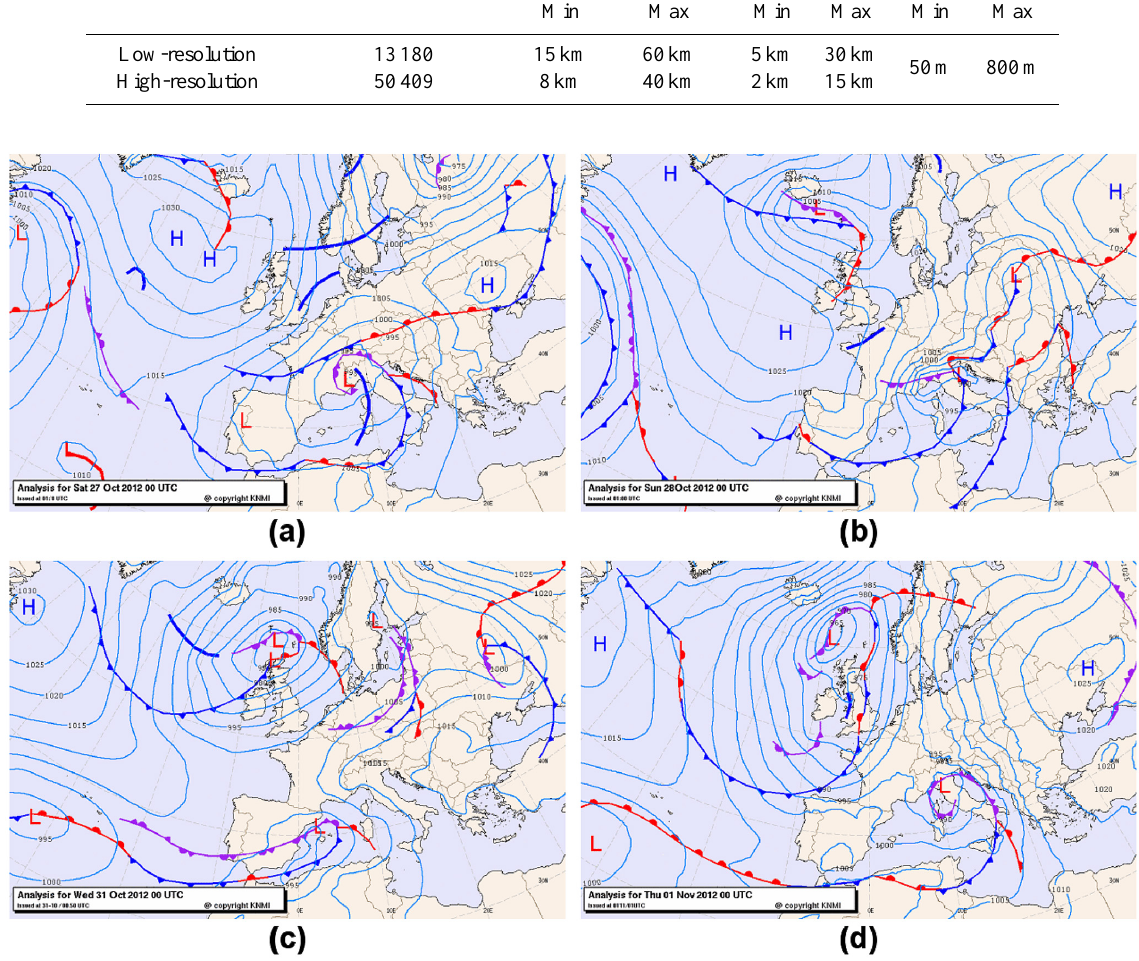
Figure 5. Synoptic analysis charts at 00:00UTC. Upper panels for IOP16: (a) 27 October 2012; (b) 28 October 2012. Lower panels for IOP18: (c) 31 October 2012; (d) 1 November 2012. Courtesy of the Royal Netherlands Meteorological Institute